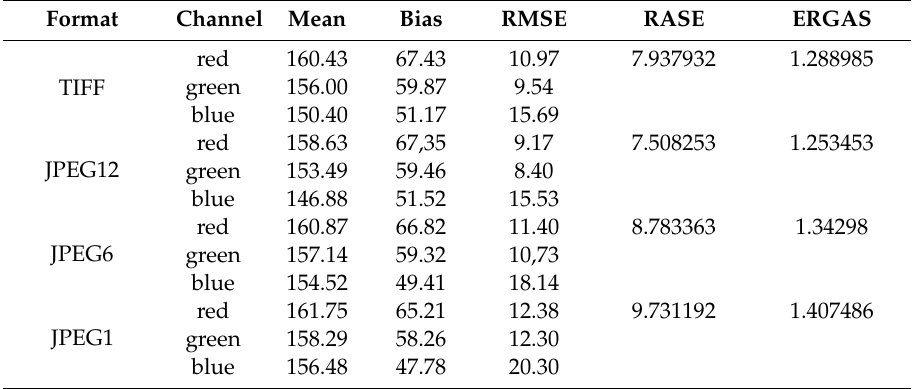
Table 16. Evaluation of the accuracy by the use of root mean square error (RMSE), relative